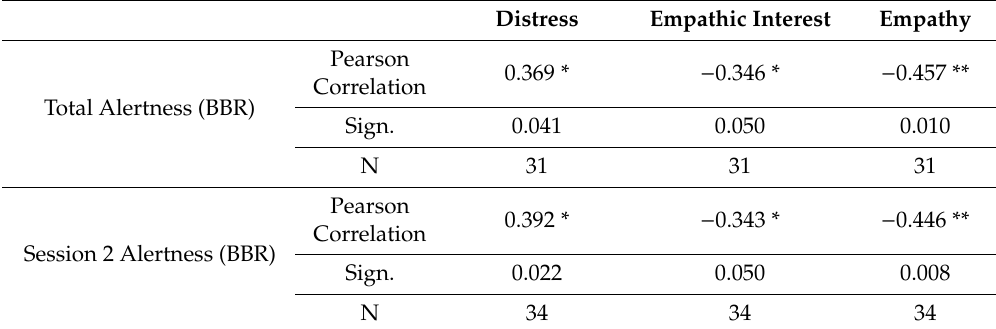
Table 1. Correlations between alertness and distress, empathic interest, and empathy.